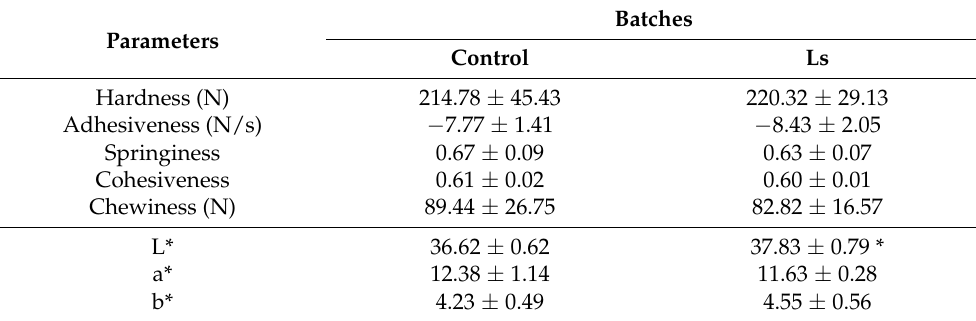
Table 3. Values of instrumental texture parameters (hardness, adhesiveness, springiness, cohesive- ness, and chewiness) and CIE L* (lightness) a* (redness) b* (yellowness) (CIELAB) of dry-cured fermented sausages (“salchich ó n”) at the end of the ripening